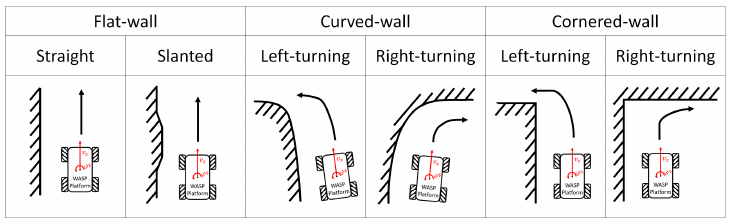
Figure 9. Different types of wall characterization considered for the